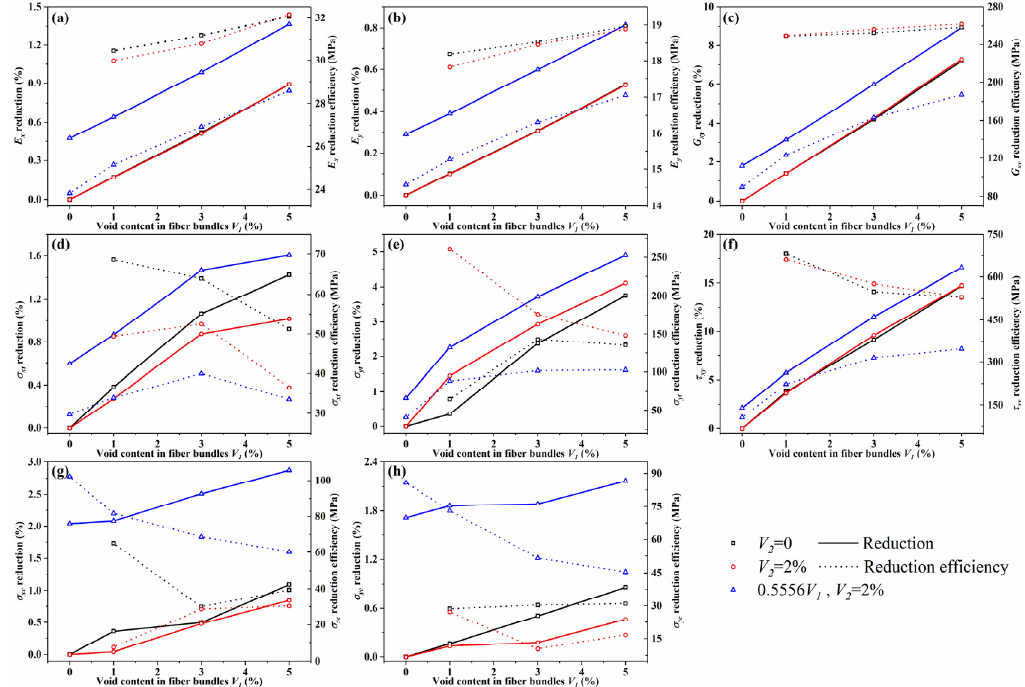
Figure 16. Reduction and reduction efficiency of mechanical properties for mesoscale models. ( a – c ) represent the modulus reduction and reduction efficiency; ( d – h ) represent the strength reduction and reduction efficiency.